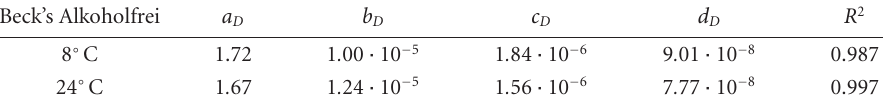
Table 3.5. Coe ffi cients of (3.12).